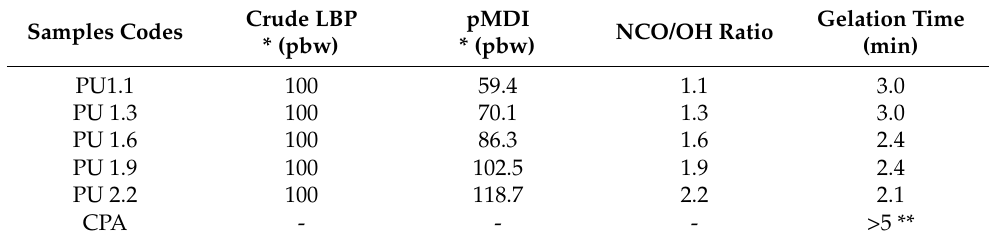
Table 2. PU adhesives formulations and their gelation time.